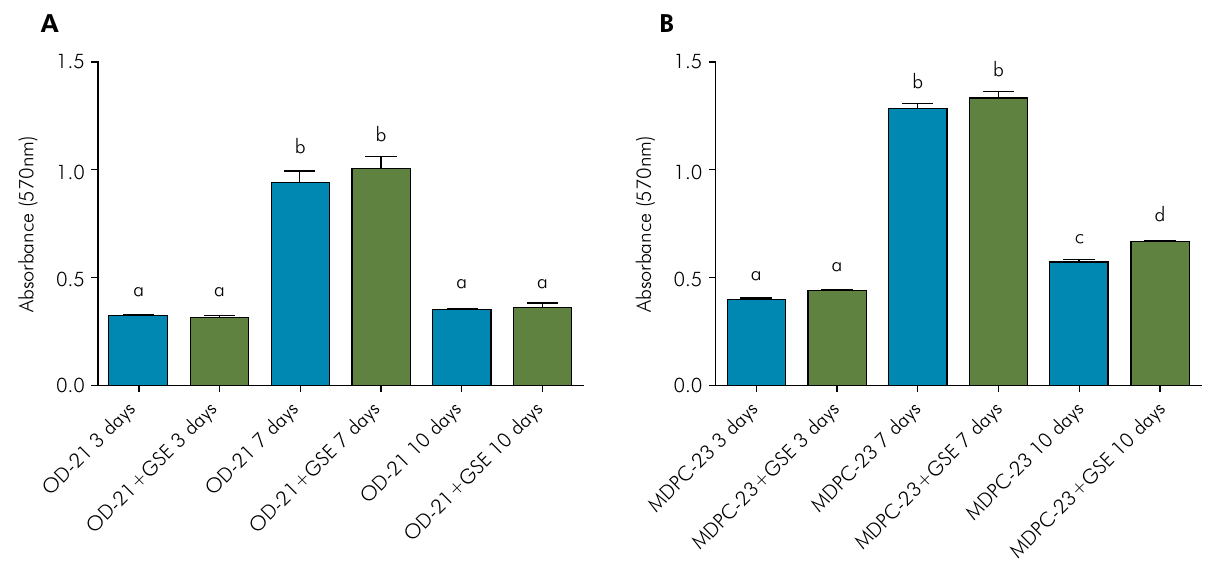
Figure 1. OD-21 (A) and MDPC-23 (B) cell proliferation by MTT assay after 3, 7 and 10 days. Different letters mean statistical difference set at 5% (ANOVA).